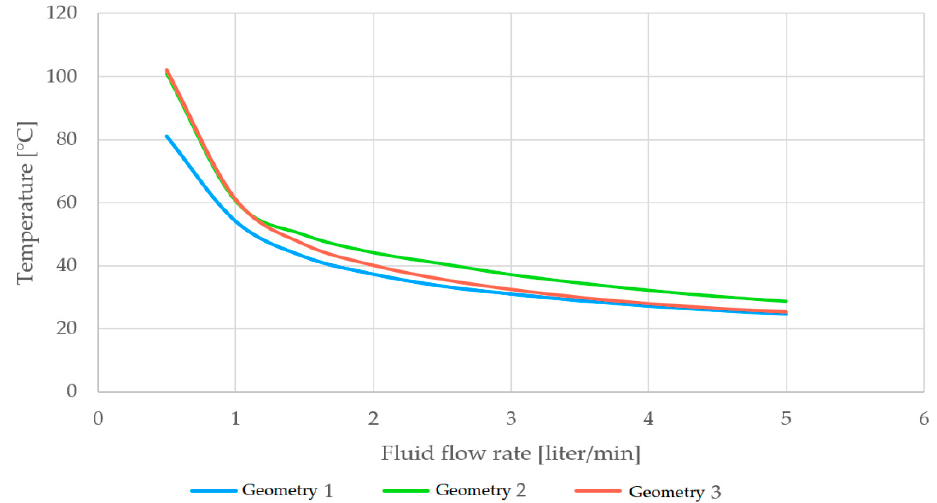
Figure 10. Comparative graph of the maximum busbar temperature as a function of flow rate and geometry for C-rate = 4.